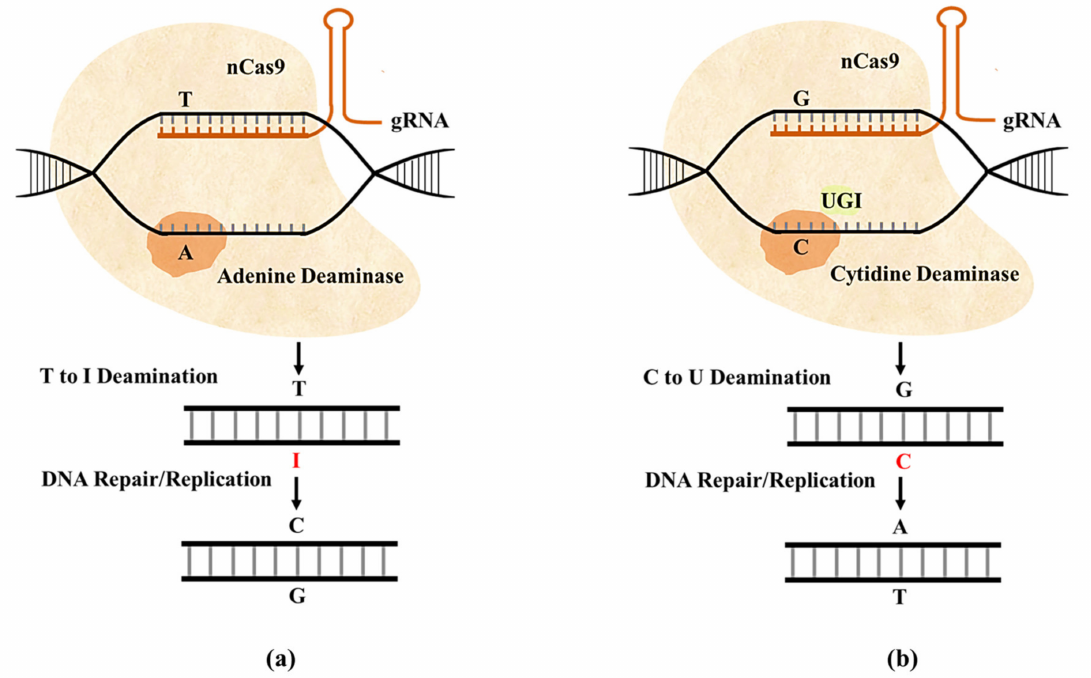
Figure 6. Schematic diagram of base editing with nickase Cas9 (nCas9). ( a ) ABE system uses nCas9 and adenine deaminase to catalyze transformation of adenine into guanine. ABE deaminates adenine to inosine (I), thus converting T-A to T-I. Repair machinery recognizes I as G and repair T-I as C-G; ( b ) CBE system utilizes nCas9 and cytidine deaminase to catalyze transformation of cytosine to uridine. Uracil glycosylase inhibitor (UGI) prevents U:G mismatch from being repaired back to C:G, and U is ultimately transformed into